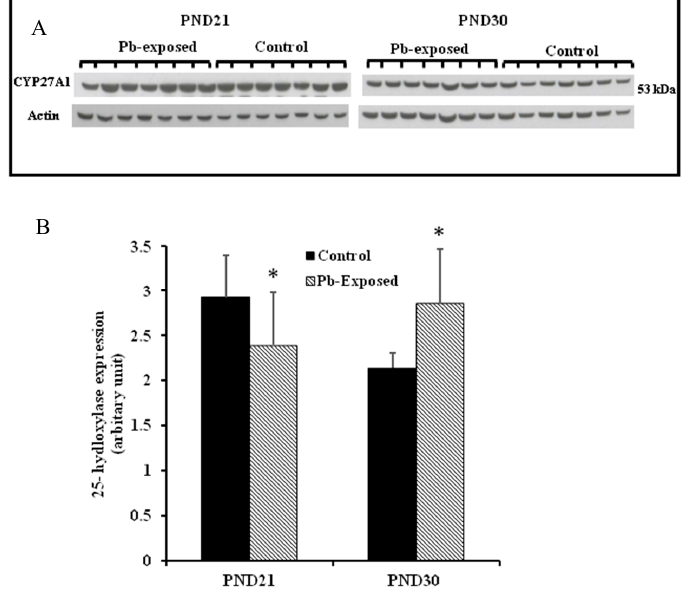
Figure 6. Effect of Pb exposure on the expression of 25-hydroxylase in the liver of Wistar rat pups: (A) Western blot analysis of liver tissue of control and Pb-exposed rats with 25-hydroxylase (CYP27A1) antibody at PND21 and PND30: 20 μ g of liver lysate was resolved on 10% SDS-PAGE and immunoblotted with antibody to CYP27A1. For loading control, the same membranes were stripped and re-probed with anti-actin antibody; ( B ) Quantification of Western blot bands at 53 kDa for 25-hydroxylase on the blots (shown in A): Blots (both CYP27A1 and actin) were scanned and the band densities quantified with Syngene gene tool software. Signal for this enzyme was normalized to signal for β -actin (loading control). Data are presented as Mean ± SD ( n = 7). * Significantly different from control ( p < 0.05).